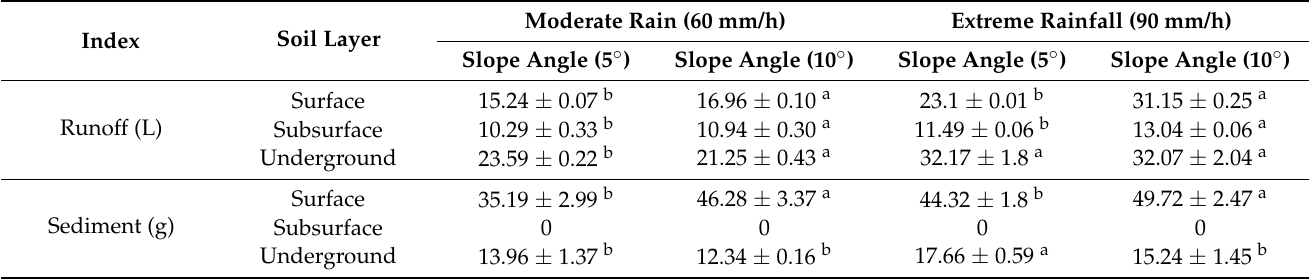
Table 1. Characteristics of soil runoff and sediment yield in Karst slope